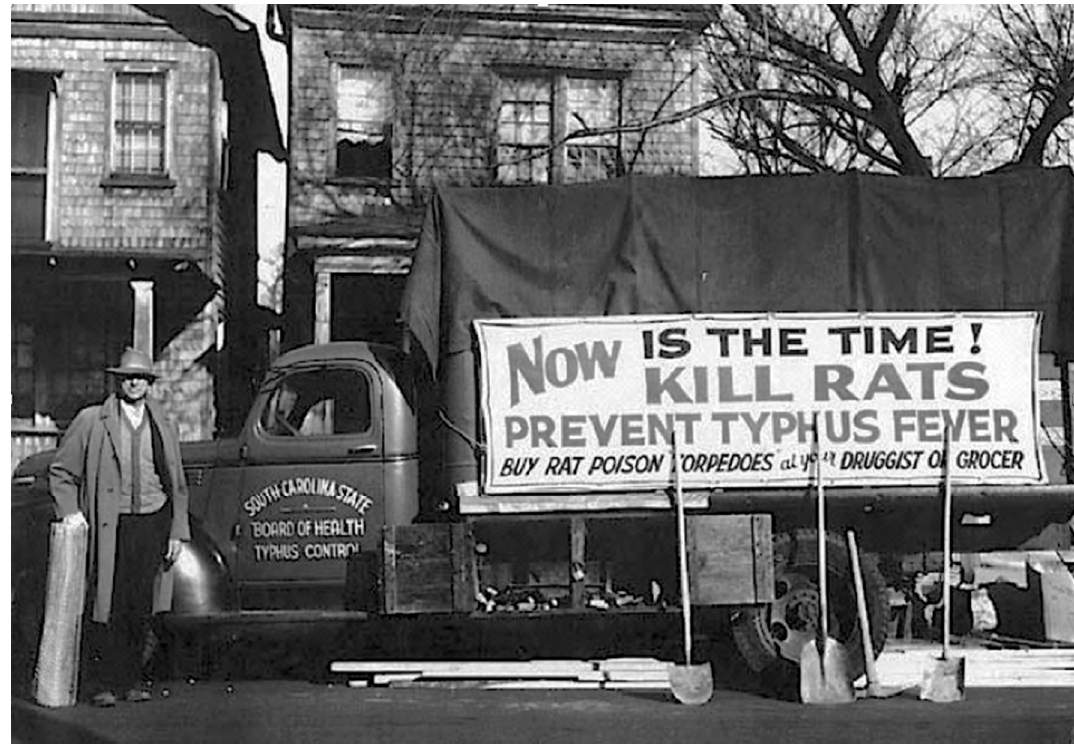
Figure 10. Truck for rat proofing, promoting the use of rat poison torpedoes. Charleston, SC, 1939.